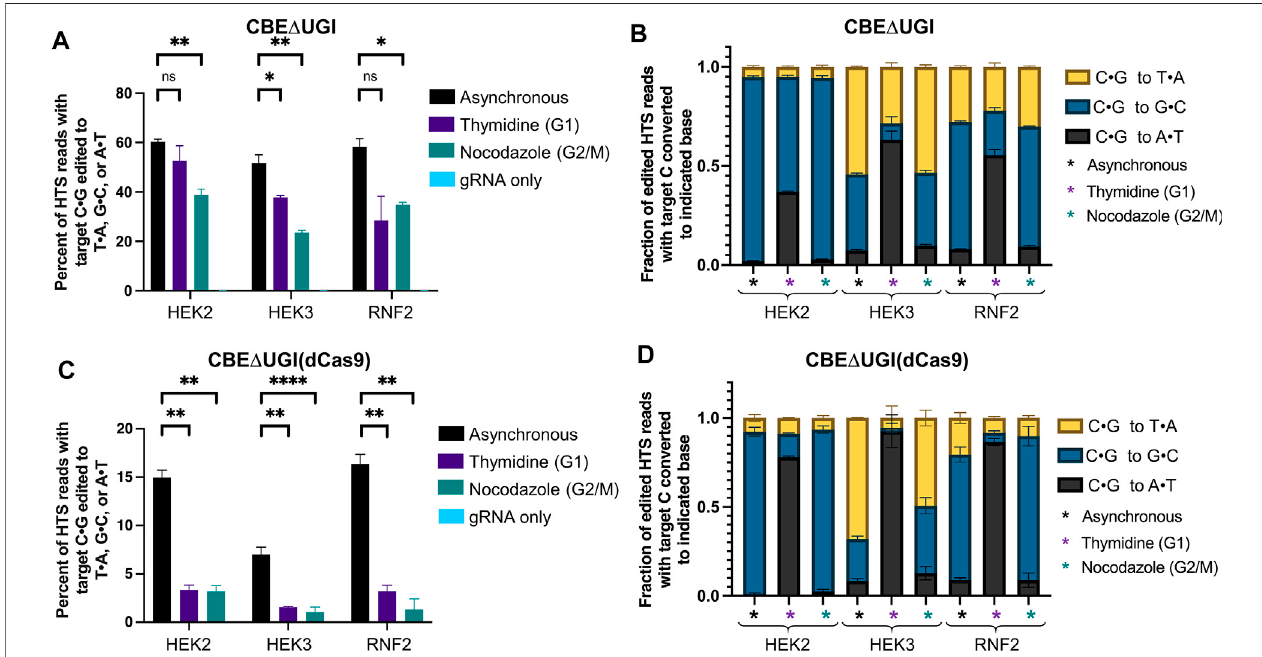
FIGURE 3 | Cell cycle synchronization effects on base editing ef fi ciencies of CBE Δ UGI and CBE Δ UGI (dCas9) in HEK293T cells. Cells were transfected with CBE Δ UGI or CBE Δ UGI (dCas9) plus gRNA (protospacer sequences indicated in Figure 1 ), synchronization agents were added 6 h post-transfection (thymidine for G1 synchronization or nocodazole for G2/M synchronization), and cells were lysed at 54 h. The genomic DNA was extracted and target loci were ampli fi ed via PCR and subjected to HTS. Genome editing ef fi ciencies (percent of total HTS reads with the target C CRISPResso2. Base editing ef fi ciencies by CBE Δ UGI (A) and CBE Δ UGI (dCas9) (C) upon synchronization are plotted. (B,D) The product distribution, de fi ned as the relative portion of edited sequencing reads (reads in which the target C plotted for CBE Δ UGI (B) and CBE Δ UGI (dCas9) (D) . Values and error bars re fl ect the means and SD of three independent biological replicates performed on different days. Asterisks re fl ect p value calculations of unpaired t test, one tailed (ns indicates not signi fi cant, * p < 0.05, ** p < 0.01, *** p < 0.001, p**** <